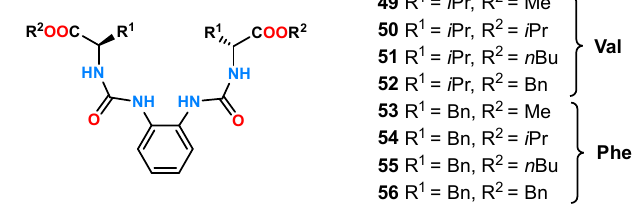
Figure 16. A library of 1,2-dimethylbenzene receptors 49–56. Very similar results were obtained as for the anthracene receptors described above.